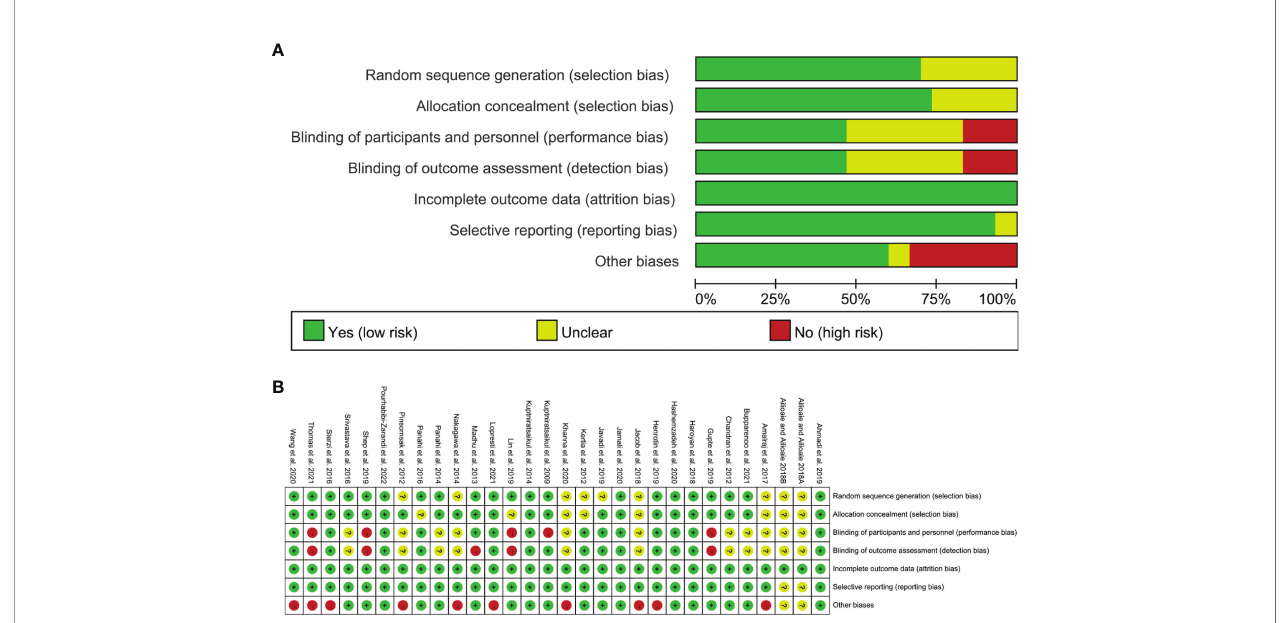
FIGURE 2 | Risk of bias [ (A) graph; (B)